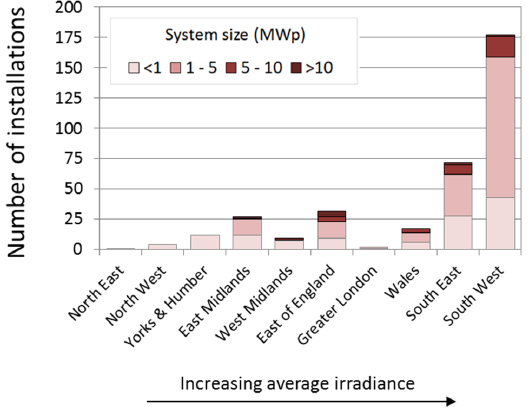
Figure 12. Regional installations of ground ‐ mount PV by system size band (MWp).